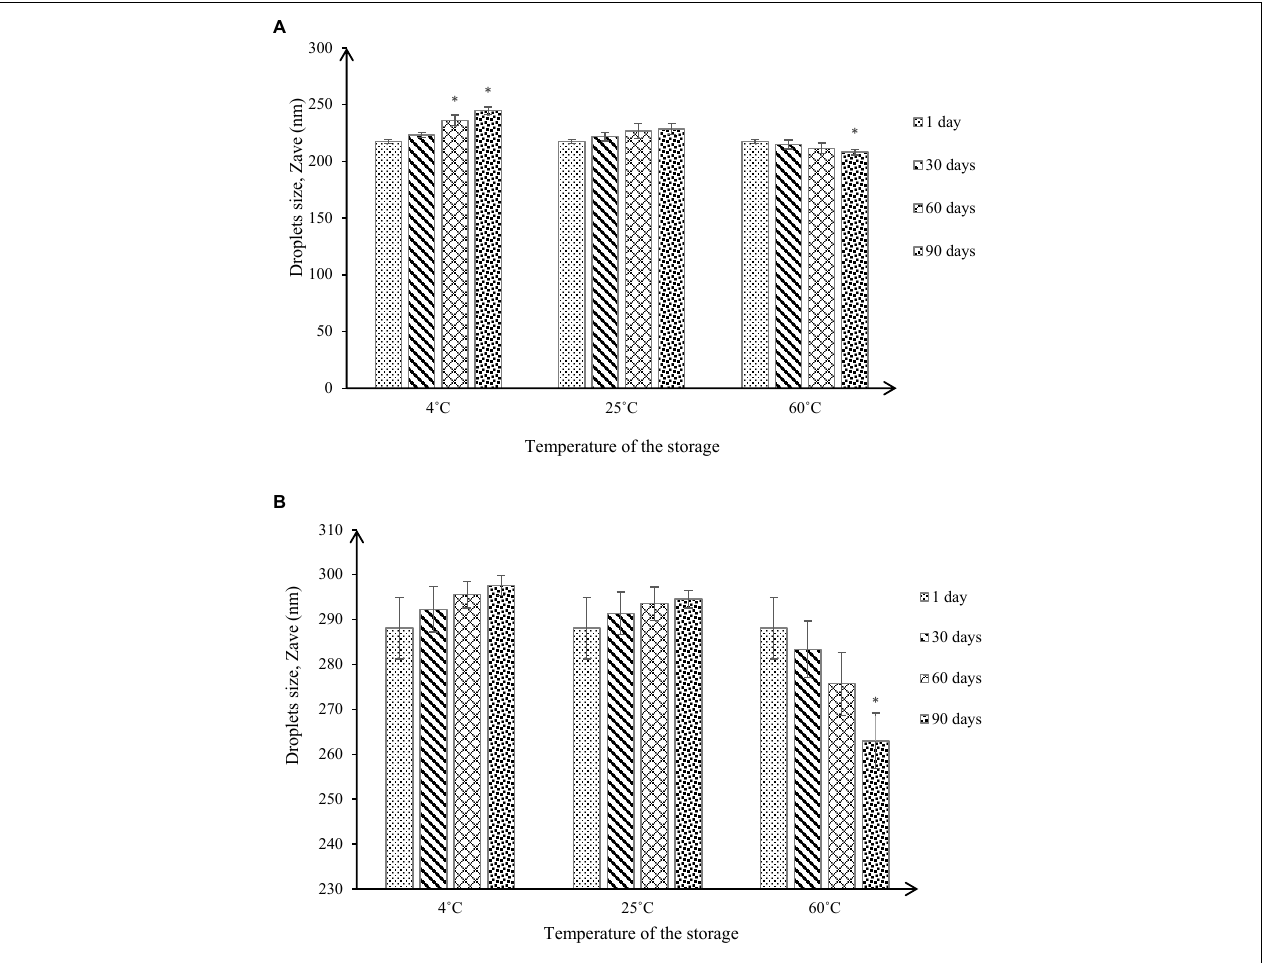
FIGURE 9 | Droplet size under different storage conditions throughout 90-day stability tests for (A) NT 6 and (B) NT 11 (mean ± SD, n = 3, ∗ p <